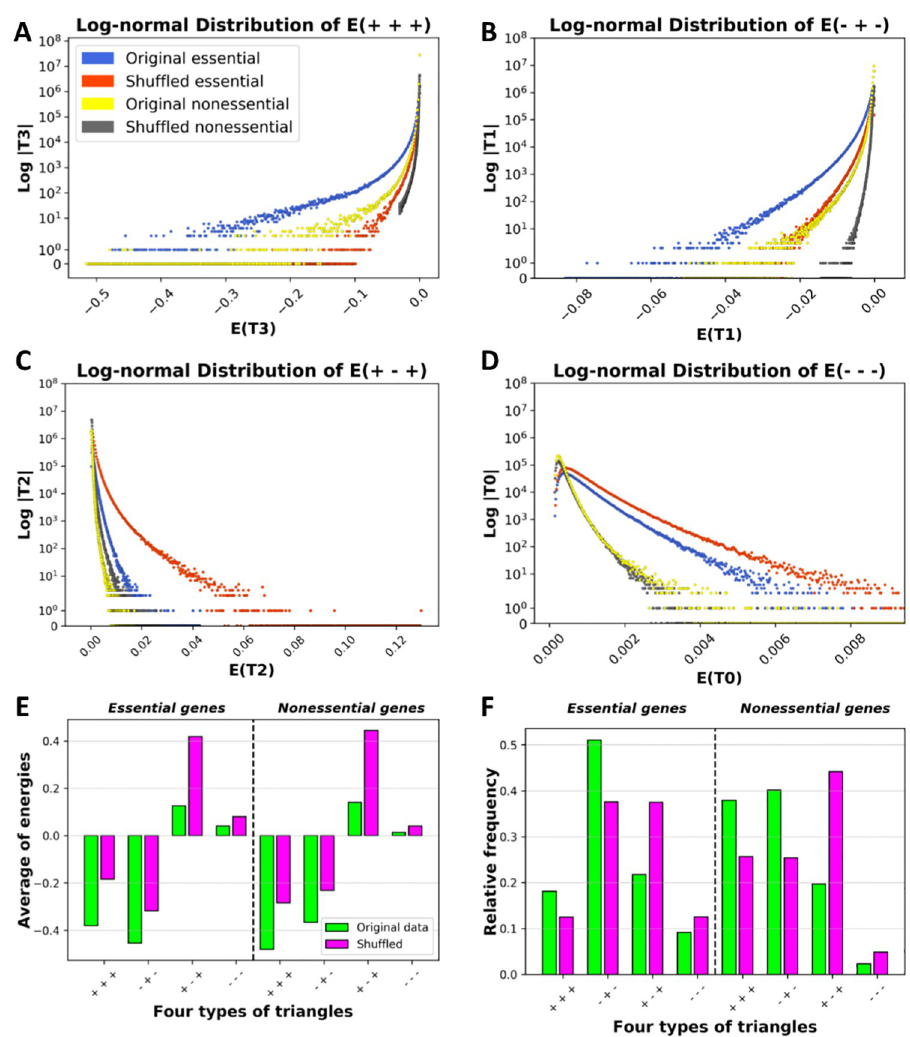
Fig 4. Energy distributions, average energy, relative frequency for all four types of triads. A: Energy distribution for strongly balanced triads, B: Energy distribution for weakly balanced triads, C: Energy distribution for strongly unbalanced triads, D: Energy distribution for weakly unbalanced triads. (The energy distribution of triads for original essential gene network and its shuffled network are plotted in blue and red, respectively. The energy distribution of triads for original nonessential gene network and its shuffled network are plotted in yellow and gray, respectively). E: From left to right, the average energy for essential gene network and nonessential gene network. F: From left to right, the relative frequency for essential gene network and nonessential gene network (Green bars for original networks and purple ones for shuffled networks).